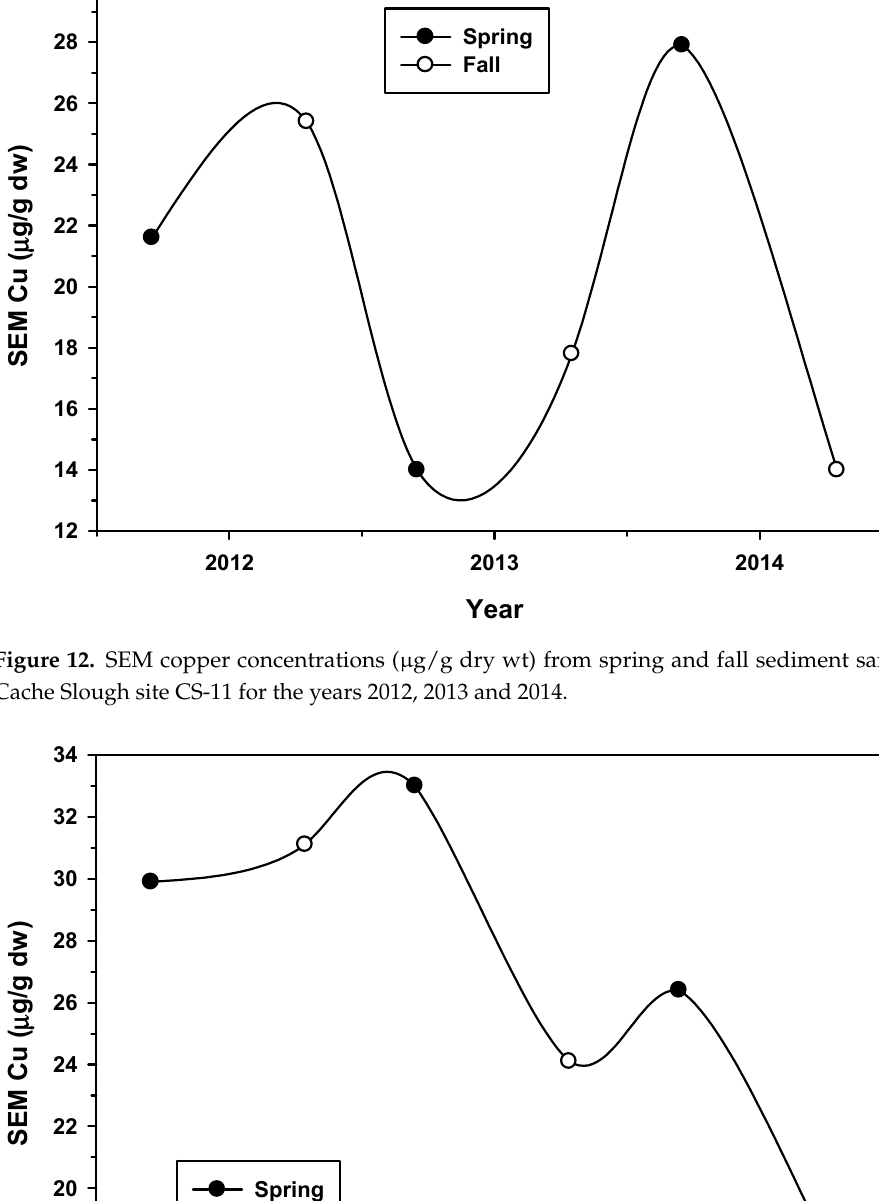
Figure 11. SEM copper concentrations (µg/g dry wt) from spring and fall sediment sampling at Cache Slough site CS-10 for the years 2012, 2013 and 2014.